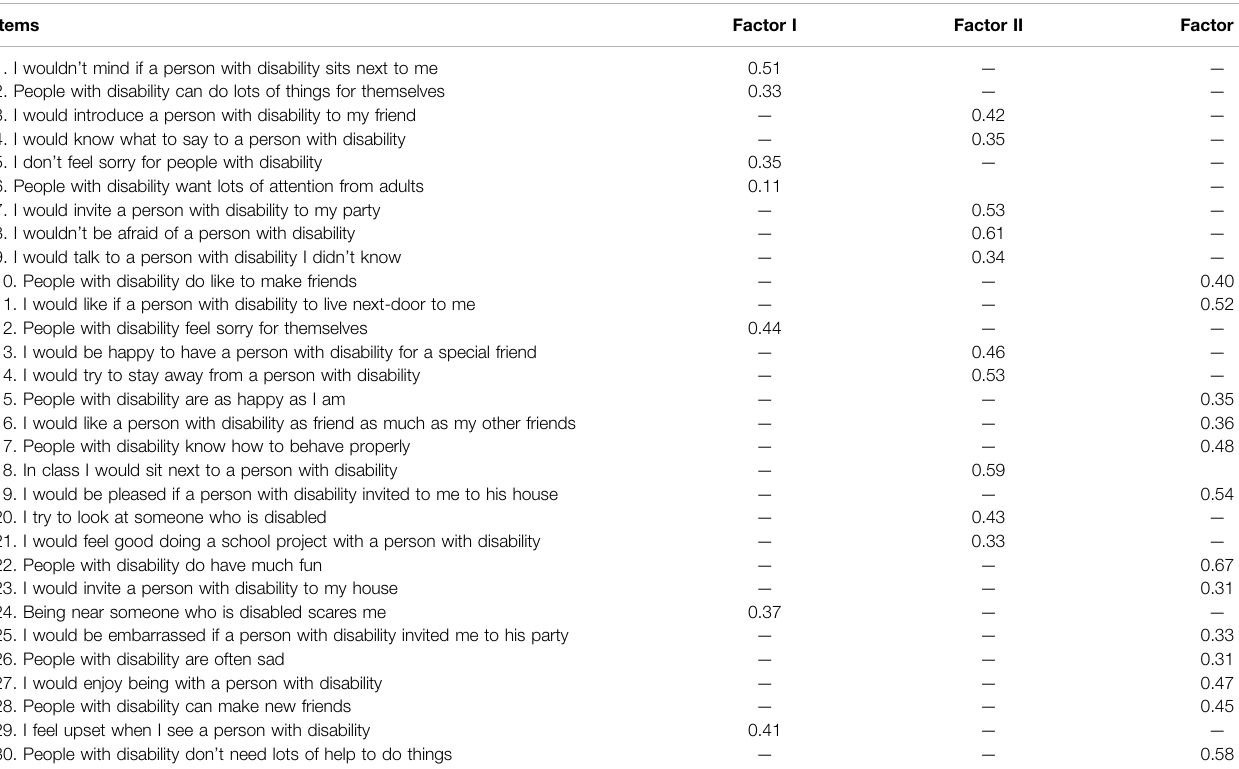
TABLE 1 | Summary of factor analysis.